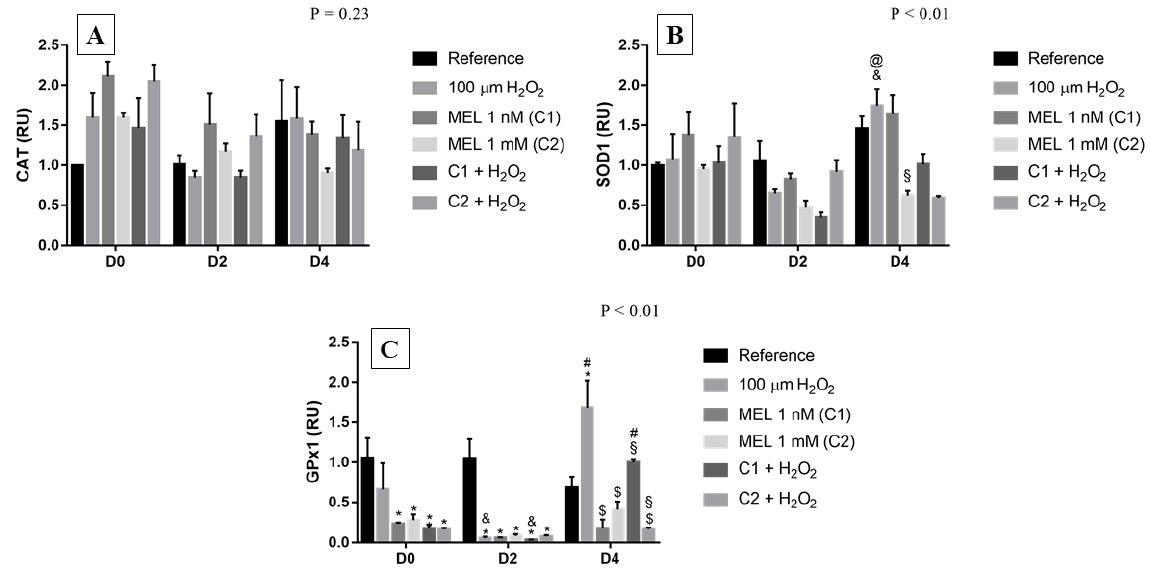
Figure 5. Relative expression of CAT , SOD1, and GPx1 in K562 erythroid cells: ( A ) CAT gene expression, ( B ) SOD1 gene expression, and ( C ) GPx1 gene expression. Reference: K562 cells without induction of oxidative stress and not treated with melatonin; 100 µM H 2 O 2 : Cells under stress induction with hydrogen peroxide; C1: cells treated with 1 nM melatonin; C2: cells treated with 1 mM melatonin; C1 + 100 µM H 2 O 2 and C2 + 100 µM H 2 O 2 : sets of cells treated with the same melatonin concentrations associated with stress induction; D0: before the differentiation, D2: beginning of cell differentiation; D4: maximum of the differentiation process. * Effects of treatments within each period compared to the respective reference groups; # Effect of the incubation period within each treatment compared to their counterparts in D0; & Effect of the incubation period between D2 and D4 within the same treatment; § Effect of C1 compared to other treatments within the same period; @ Effect of C2 compared to other treatments within the same period; $ Effect of melatonin; Test performed: GLM with 2-way ANOVA design, complemented by Bonferroni test.